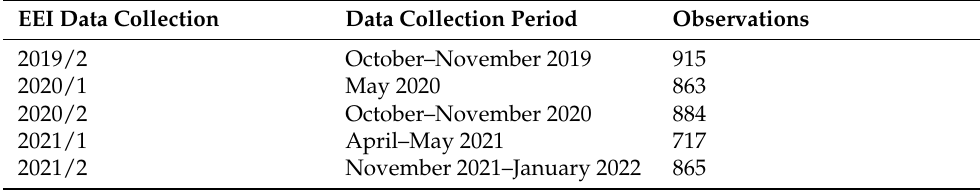
Table 1. Energy Efficiency Index of German Industry (EEI) datasets referred to [39–43]. EEI Data